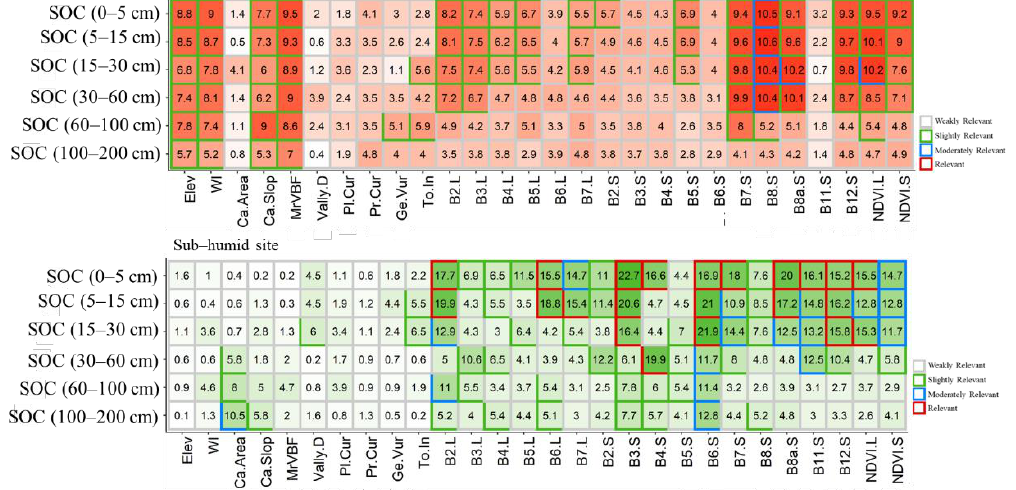
Figure 5. Optimal covariate selection using Boruta algorithm for SOC content at six standard depths at the two regions. The covariate is defined in Table